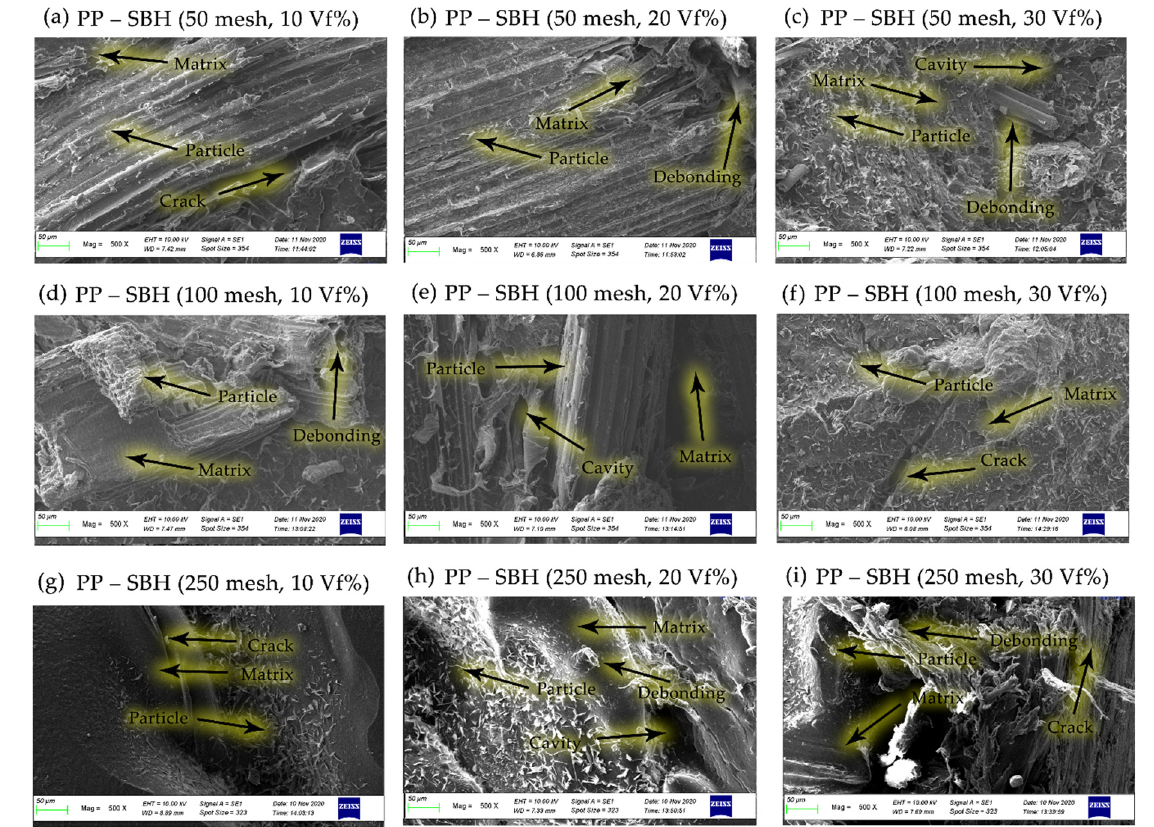
Figure 17. SEM micrographs on the morphology of the PP–SBH composites.